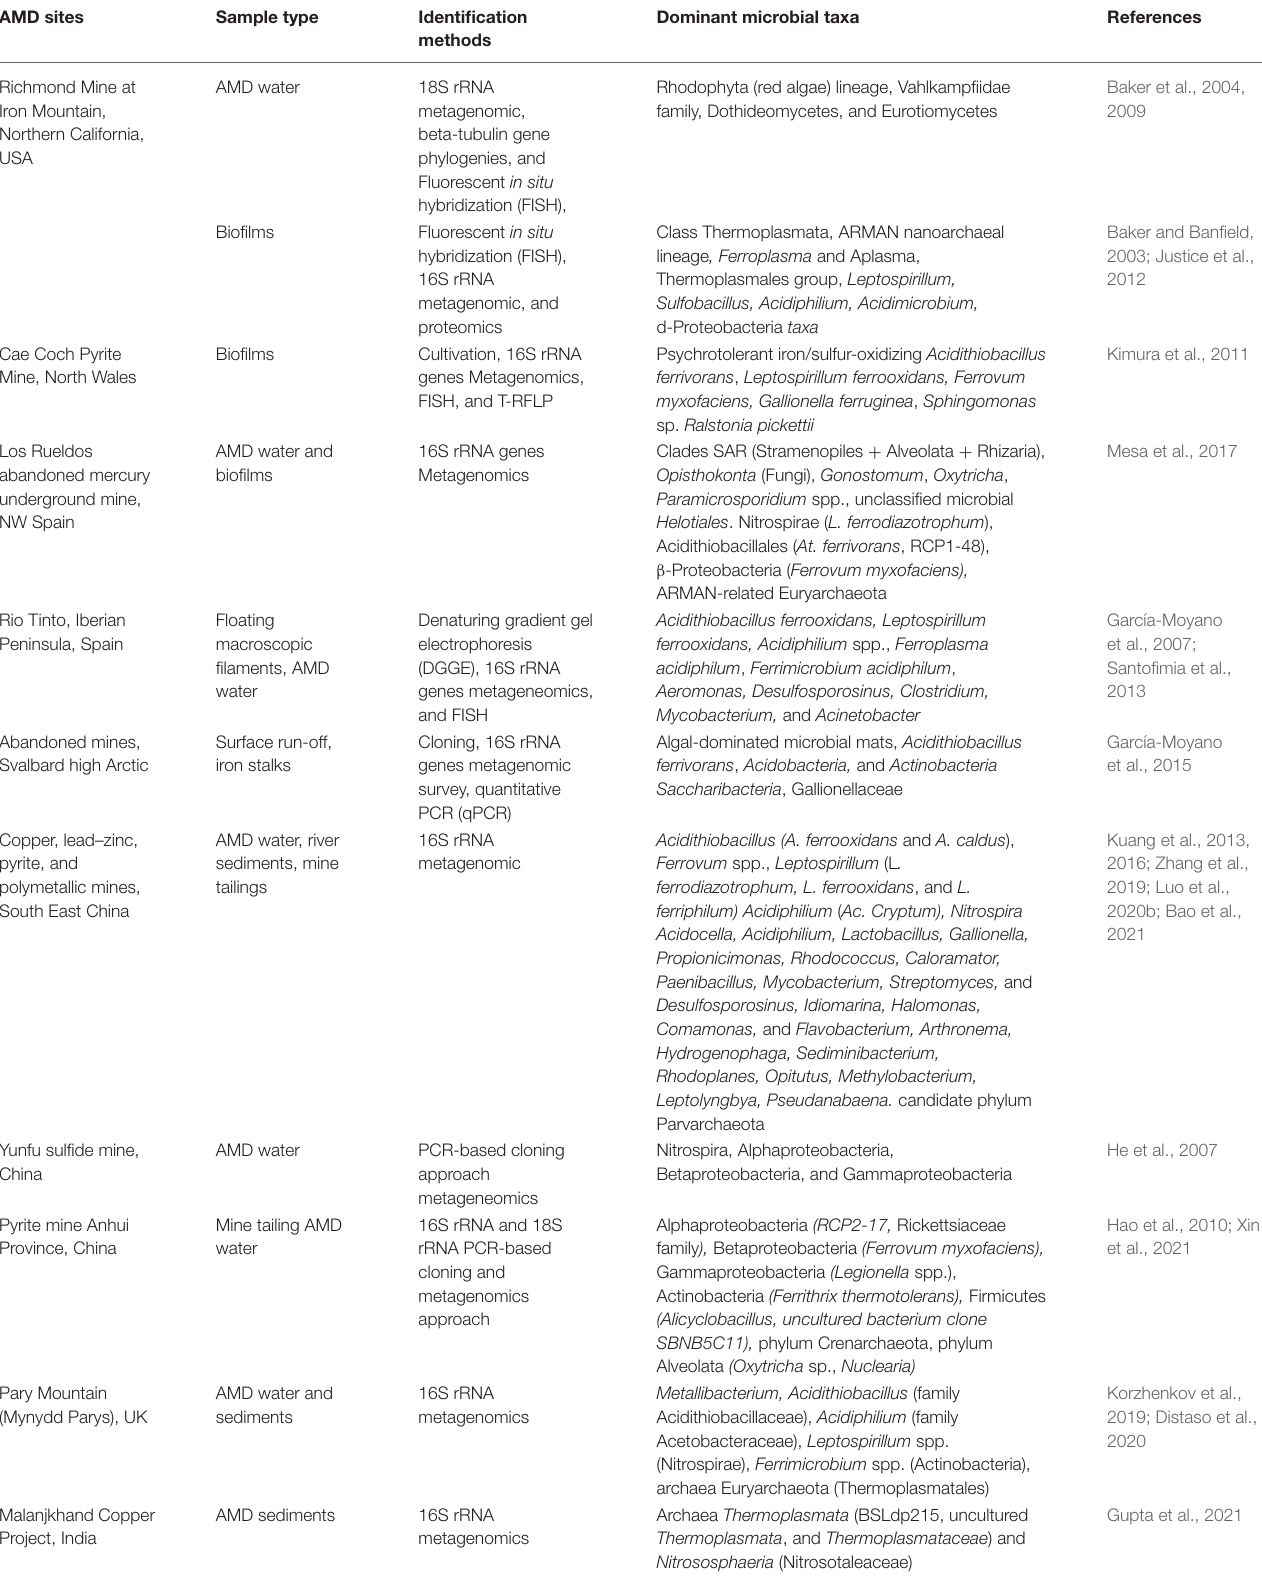
TABLE 1 | Microbial diversities associated with selected AMD sites across the